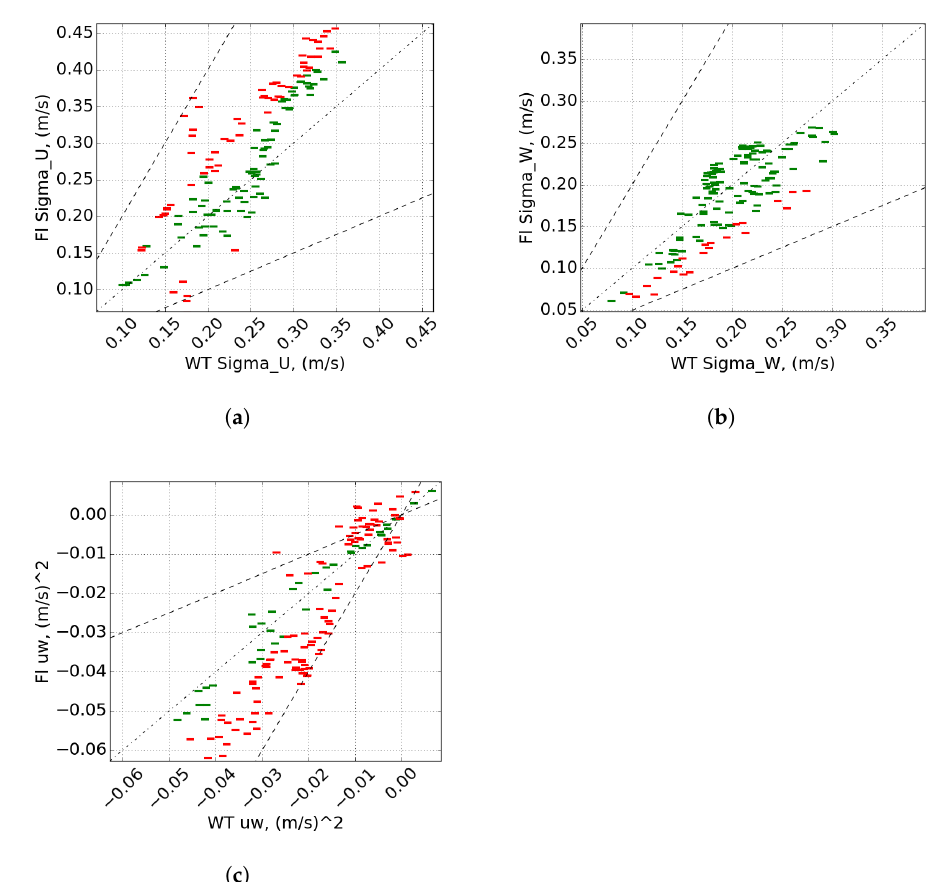
Figure 6. Scatter plots of ( a ) σ u , ( b ) σ w and ( c ) u (cid:48) w (cid:48) for the wind tunnel and LES. Green markers indicate values which meet the criteria, red markers indicate values which do not meet the criteria. Dotted line is the x = y line, dashed lines are the factor 2